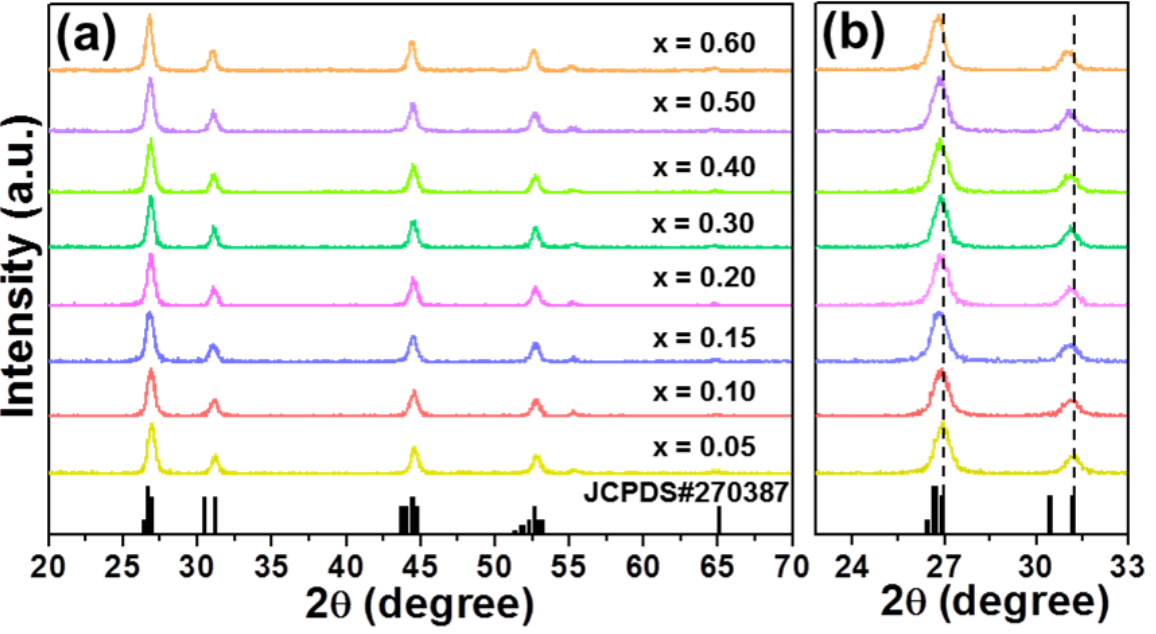
Figure 1. ( a ) XRD patterns of KGd 2 F 7 :2 x Eu 3+ (0.05 ≤ x ≤ 0.60) nanoparticles. ( b ) Zoomed XRD patterns of KGd 2 F 7 :2 x Eu 3+ (0.05 ≤ x ≤ 0.60) nanoparticles in the 2θ range of 23– 33°.